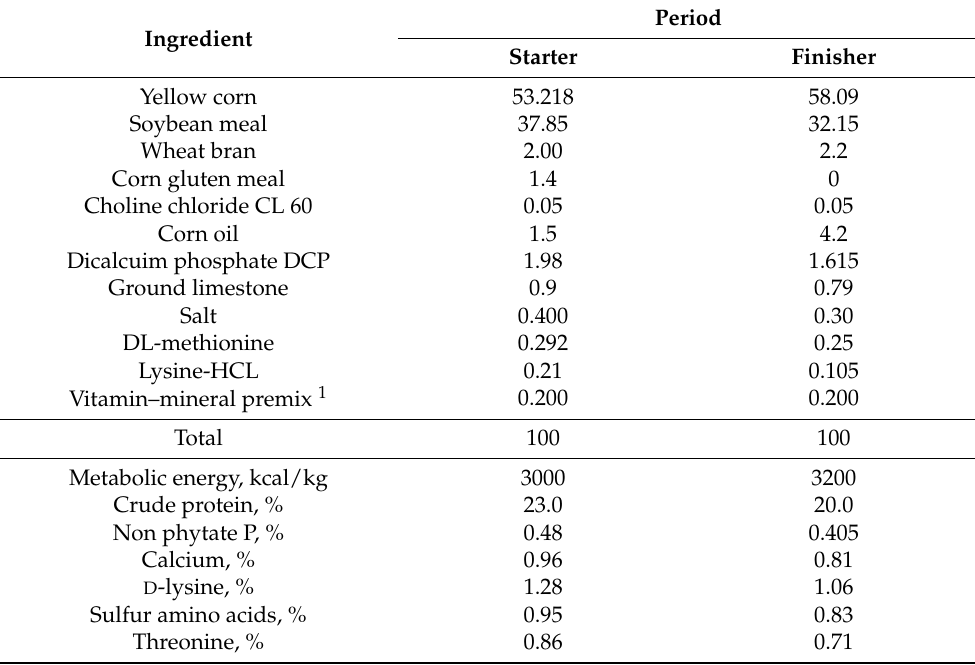
Table 1. Ingredients and calculated nutrients of broiler starter and finisher